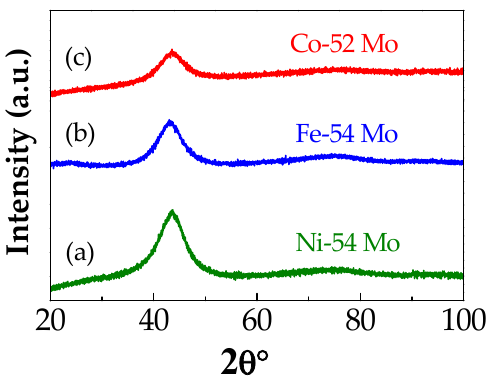
Figure 2. XRD pattern for: ( a ) Ni–54 Mo, ( b ) Fe–54 Mo and ( c ) Co–52 Mo electrodeposits (composition is given in at.%).